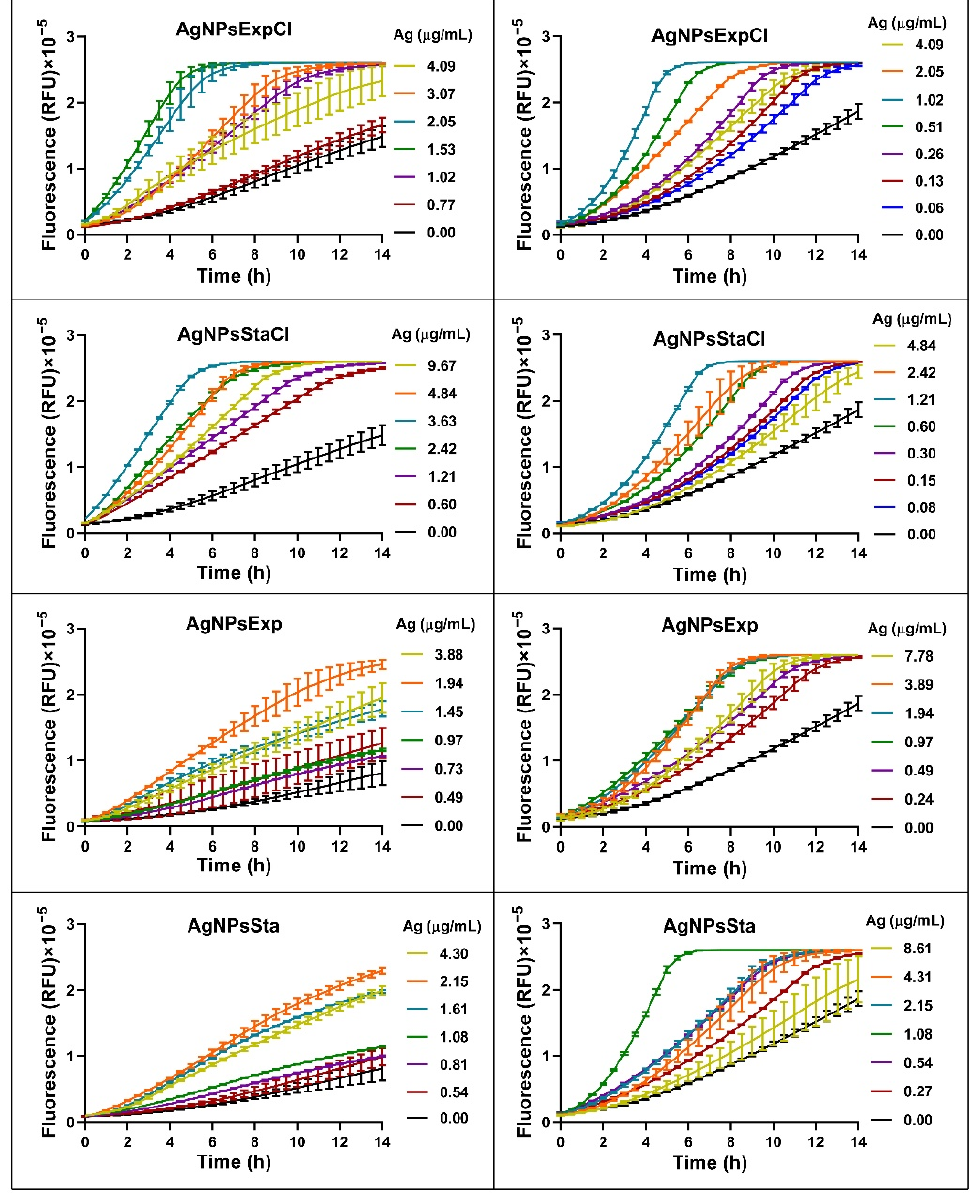
Figure 8. Kinetics of ROS production over time by cultures of E. coli ATCC 25922 ( left panels ) and S. aureus CECT 794 ( right panels ) in the presence of AgNPs. RFU: relative fluorescence units.